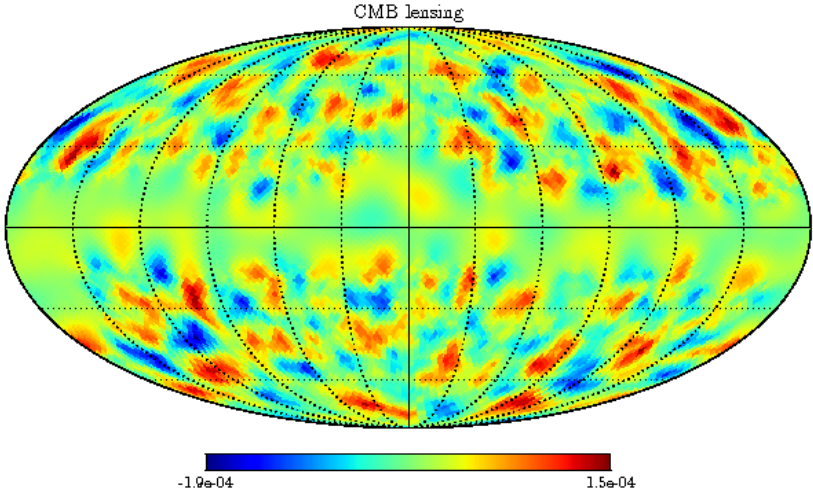
Figure 13. Sky map of the gravitational-lensing potential reconstructed from the CMB temperature fluctuations as measured by the Planck satellite (signal reduced along the galactic plane to avoid Figure 14. All-sky map of the CMB lensing potential constructed from the Planck 2015 data. Lighter regions correspond to integrated overdensities, darker to underdensities. The grey regions, where Galactic and extragalactic foregrounds are large, are masked in the analysis. Image credit: ESA and the Planck Collaboration.